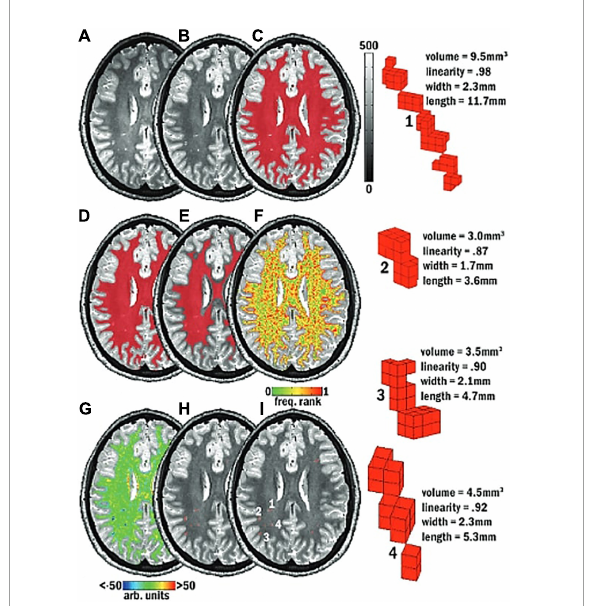
FIGURE6 Schematic of the mMAPS (multi-modal auto-identification of perivascular spaces) pipeline for the automated segmentation of PVS adapted from Piantino et al. (2020). It relies on the sequential application of image filters, intensity thresholds, and morphological constraints to delineate PVS voxels. (A) A T2-weighted MRI image is acquired. (B) Voxel intensities are normalized. (C) White matter (WM) mask (red) applied. (D) Holes in the WM mask are filled. (E) Edges of the WM mask are eroded. (F) Frequency map of the voxel intensities. (G) Map of the local intensity differences. (H) Seed clusters resulting from the previous steps are extracted and filtered with morphological constraints. (I) The final segmentation map. Reproduced with permission of the American Society of Neuroradiology, from Piantino et al. (2020), conveyed through the Copyright Clearance Center,